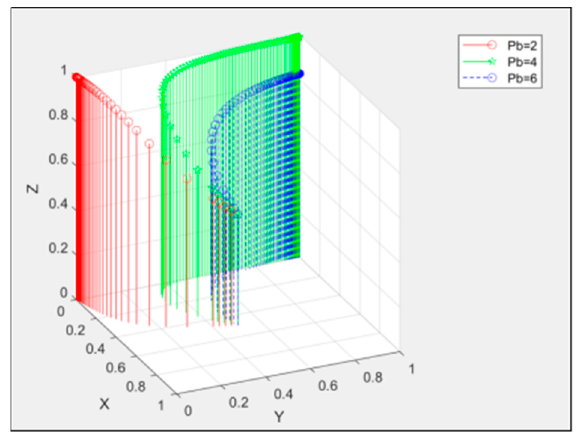
Buildings 2022 , 12 , x FOR PEER REVIEW